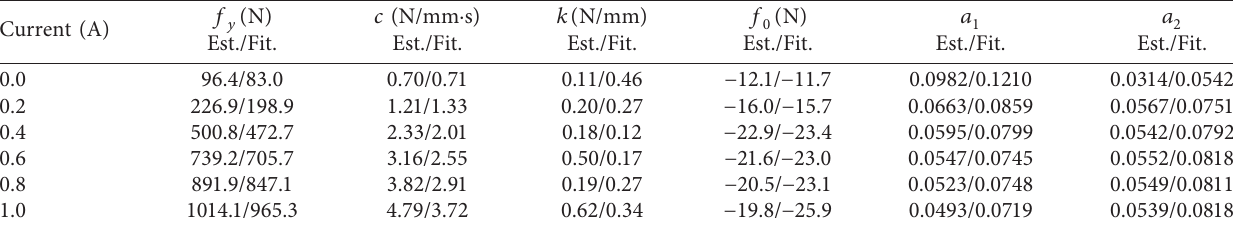
Table 2: Model parameters under harmonic excitation.